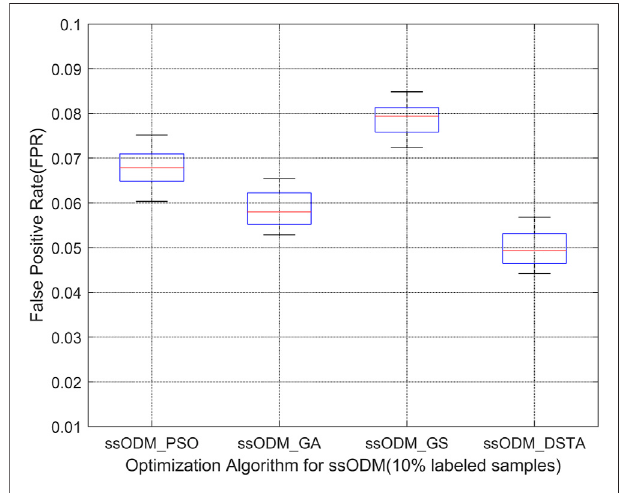
FIGURE 11 | Boxplot of FPR of low-temperature fault detection regarding the blade 2 axle box of the pitch (5% labeled samples).